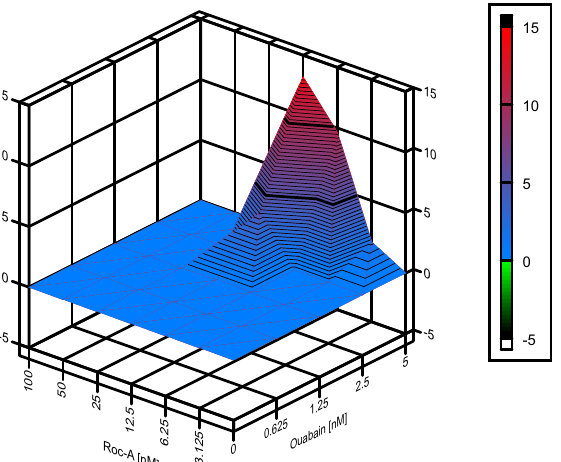
Fig 7. Synergistic antiviral effect of ouabain and rocaglamide on rLCMV/eGFP multiplication. A549 cells seeded (2.0 x 10 4 cells/well) in 96-well plates and cultured overnight were treated with combinations of ouabain and Roc-A at indicated concentrations for 2 h and then infected (MOI = 0.01) with rLCMV/eGFP. Compounds were present throughout the end of experiment. At 48 h pi, cells were fixed and stained with DAPI. eGFP and DAPI signals were measured by a fluorescent plate reader. eGFP signal was normalized to DAPI signal, and the normalized data were used to analyze synergistic effect by MacSynergy II software. Data represent % synergy (% inhibition over the expected [additive effect]) at the 95% confidence interval from five independent